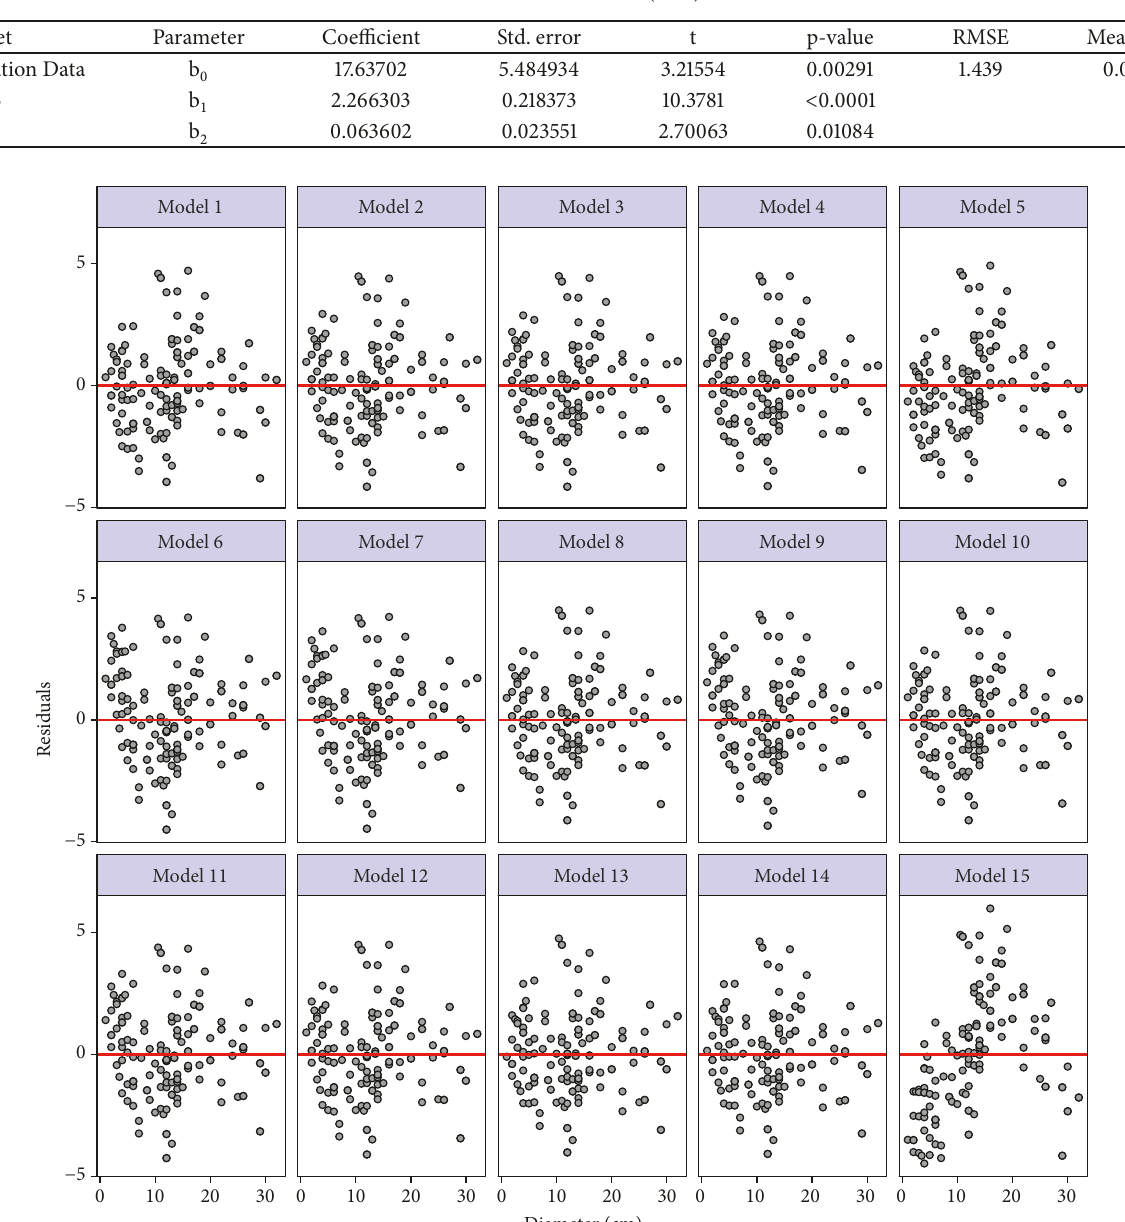
Table 6: Prediction statistics of the best model (M14) for validation dataset.